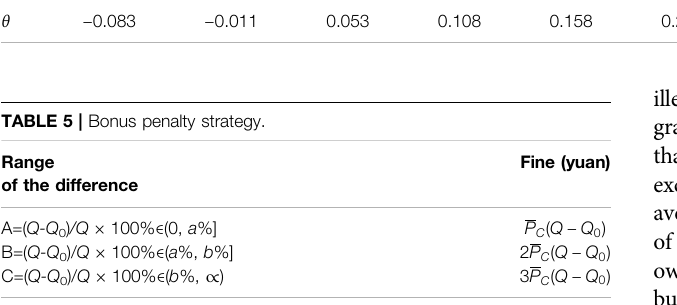
Table 4 . After the costs of technology-based emission reduction